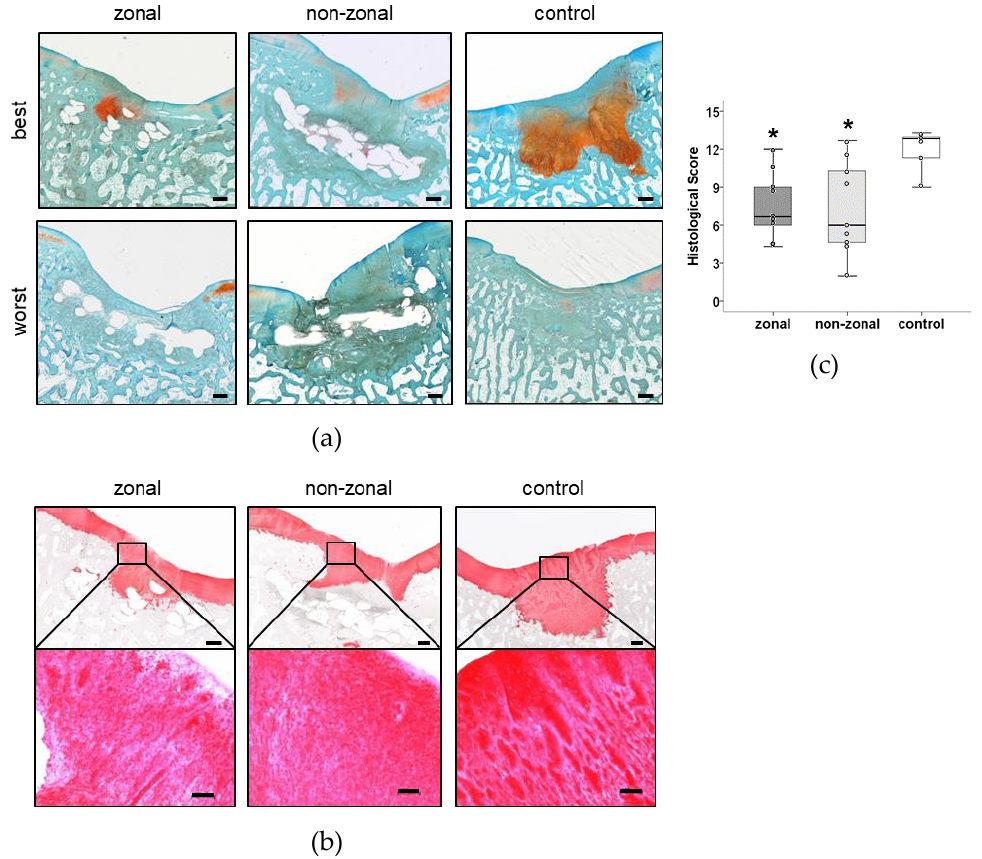
Figure 6. Evaluation by modified O’Driscoll score. ( a ) Best and worst results per group according to histological scoring. Safranin O/Fast Green staining. Scale bar: 500 µm. ( b ) Best cell morphology and collagen type II deposition of regeneration tissue in each group after 6 months in vivo. Top: overview. Scale bar: 500 µm. Bottom: area of magnification. Scale bar: 100 µm. ( c ) Histological evaluation of defect repair after 6 months in vivo rated by three blinded observers using a modified O’Driscoll score. Boxes represent first and third quartiles, medians are given as horizontal lines, whiskers are maximal and minimal values, individual values (mean of all three observers) are depicted as circles. *: p ≤ 0.05 vs. control (MWU, Bonferroni correction). Zonal n = 9, non-zonal n = 9, control n = 6.